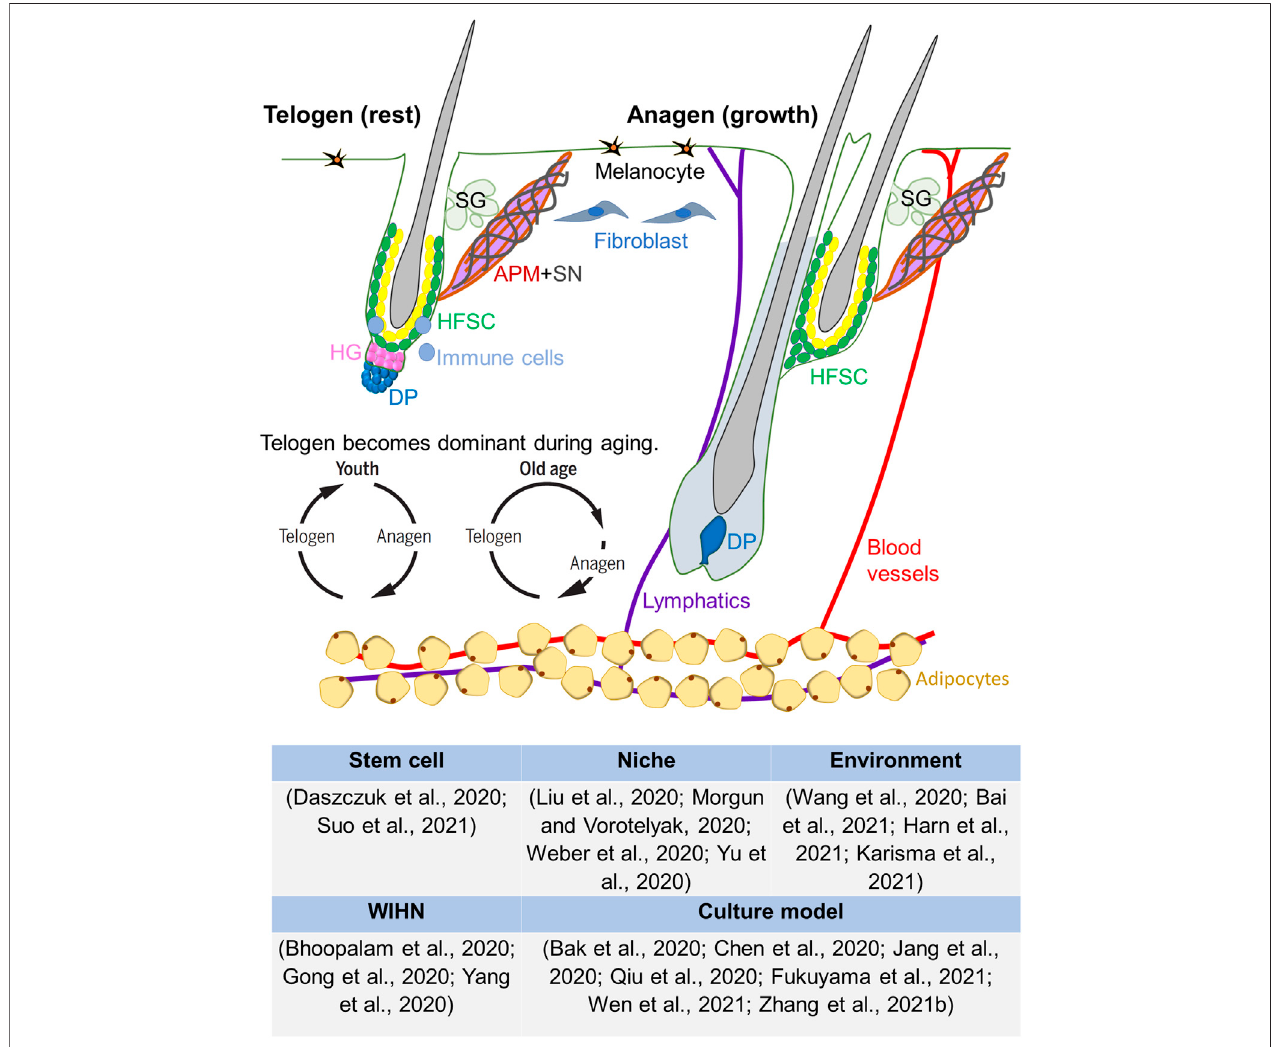
FIGURE 1 | Hair follicle stem cell regeneration in aging. Hair follicle undergoes cyclic renewal, which is regulated by cyclic activation of quiescent stem cells controlled byacore circuit involvingbeta-catenin. This coremolecularcircuitinvolves interactionsbetween hair follicle stem cell(HFSC) and dermal papillawithin the hair follicle. Adjacent to the follicles, blood vessels, nerves, arrector pili muscle, intradermal adipose tissues, etc. form a larger niche that also can affect HFSC activation. Further,outsideenvironmentcanalsomodulatethecyclicrenewalbehaviorofhairfollicles.Theeffectsofthesemodulatorschangeduringaging.Thetelogenphase ofthehaircyclebecomesdominantduringaging,leadingtodecreasedhairregeneration.Agedcellscanbereactivatedtoregenerate hairfolliclesunderwound-induced hair neogenesis condition or using several 2D or 3D culture models. APM, arrector pili muscle; DP, dermal papilla; HFSC, hair follicle stem cells; HG, hair germ; SG, sebaceous gland; SN, sympathetic